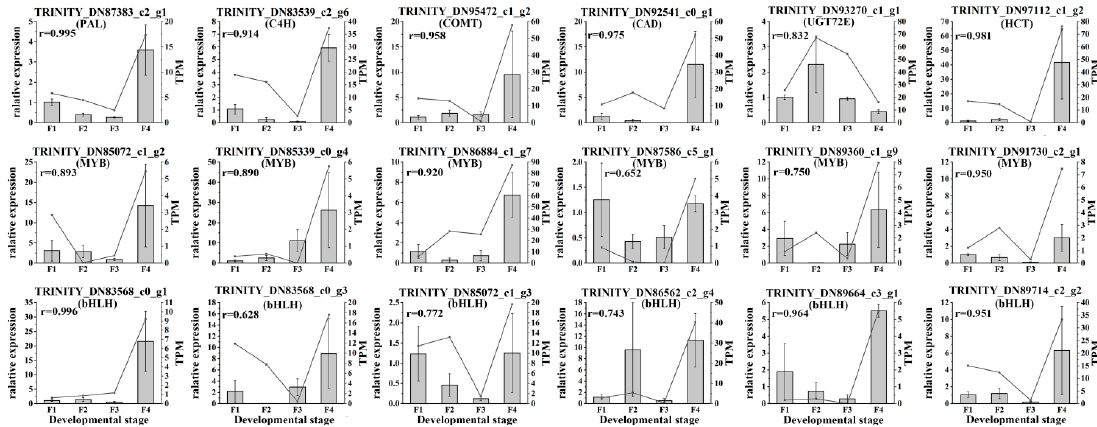
Figure 6. Real-time polymerase chain reaction (PCR) validation of candidate unigenes involved in Cyclocarya paliurus phenolic acid biosynthesis by RNA-seq. The histogram shows the relative gene expression obtained via real-time PCR. The transcripts per million (TPM) of each million mapped fragments of the transcriptome are represented with a line graph. The right y -axis indicates gene expression levels calculated as TPM. The left y -axis indicates relative gene expression levels obtained via real time PCR.